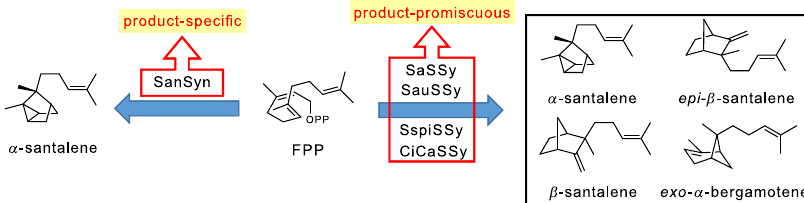
Fig. 1 The product-promiscuous and product-speci fi c santalene synthases. SaSSy, SauSSy, SspiSSy, and CiCaSSy produce the multiple santalene products, and SanSyn predominantly produce α